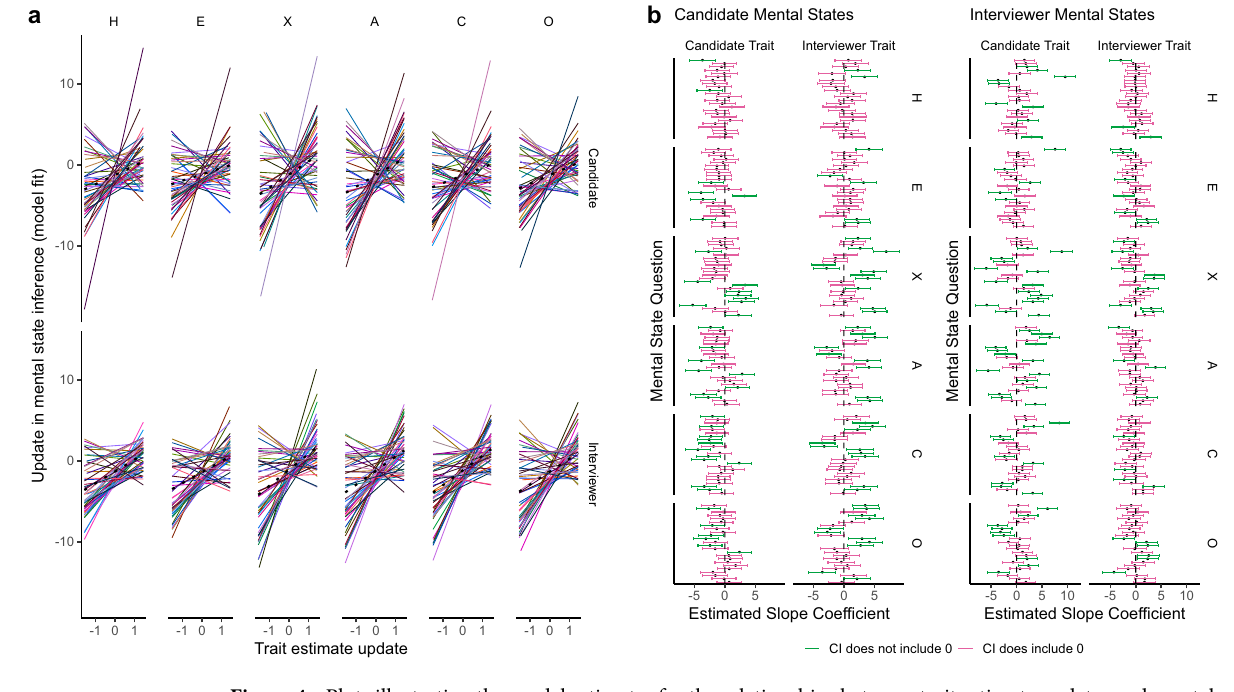
Figure 4. Plots illustrating the model estimates for the relationships between trait estimate updates and mental state inference updates in the Interview Task. (Panel a ) The specific relationships between updates in estimates of individual traits (given along the top), for specific Targets (given on the right), and different mental states (represented by different colours). The black dotted line represents the overall effect for that trait and Target. The graphs show that the relationships between specific trait updates and specific mental state updates vary such that, for some questions, a trait increase might be related to a mental state inference increase, but for others the relationship may be reversed. Similarly, the trait might not be relevant at all to the mental state, resulting in a flat line. (Panel b ) The estimated slopes for the effect of specific trait estimate updates (given on the right) for specific Targets (given along the top) on specific mental states (represented by separate lines). The estimated slopes for inferences about the Candidate’s mental states are given to the left, those for the Interviewer’s mental states are given to the right. Error bars are 95% confidence intervals and green lines indicate that the confidence interval does not include zero, whilst pink lines indicate that it does. This graph therefore further shows that these relationships vary between traits, i.e., each trait has a unique set of mental states which it is related to, each with its own extent and direction, and that both Targets’ minds are considered in mental state inference.